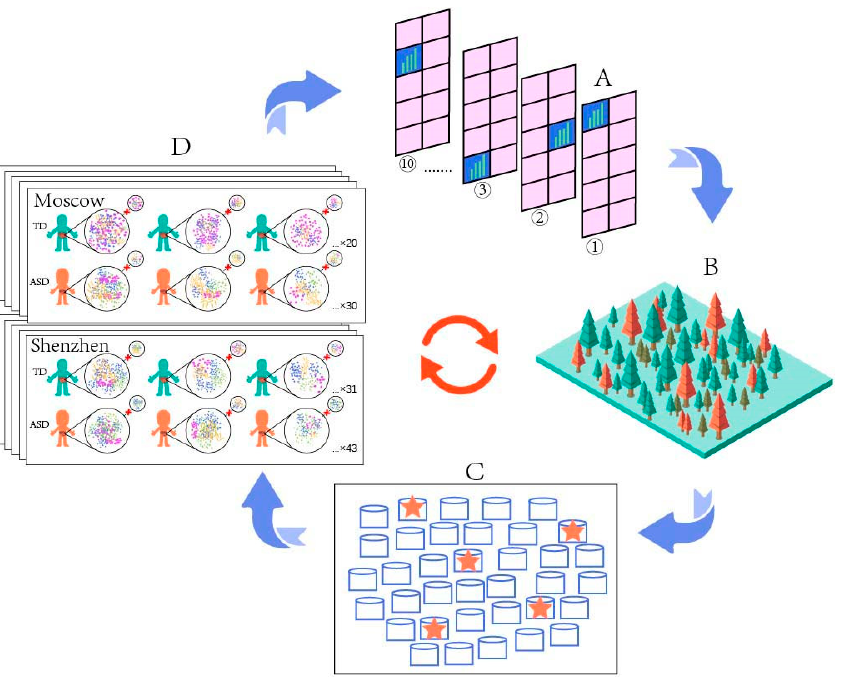
Figure 2. The main interactive processes of our random forest algorithm. ( A ) Stratified 10-fold cross-validation was conducted with a dataset divided into training and test sets. ( B ) A total of 100 repeats of stratified 10-fold cross-validation were run, and five models with the highest AUROC values were singled out ( C ). ( D ) After removing the unimportant species with a value of mean decrease accuracy less than or equal to 0, the rest of the species were utilized to run the next round of 100 repeats of stratified 10-fold cross-validation. The iteration was repeated until little or no increase in the AUROC value was reached (AUROC value < 0.01), and the corresponding model was optimal.